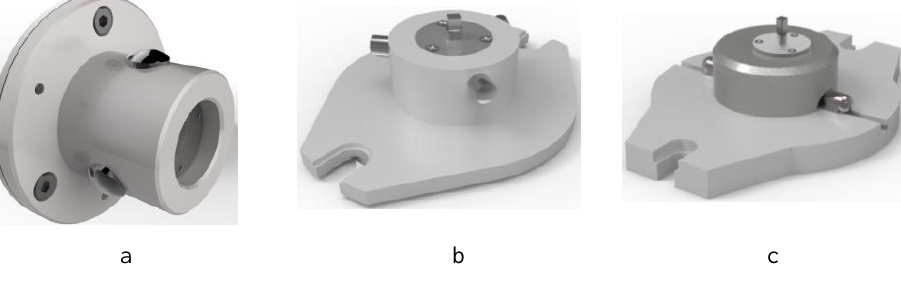
Figure 4. Adjustable locating modules for locating of parts according to internal cylindrical surfaces